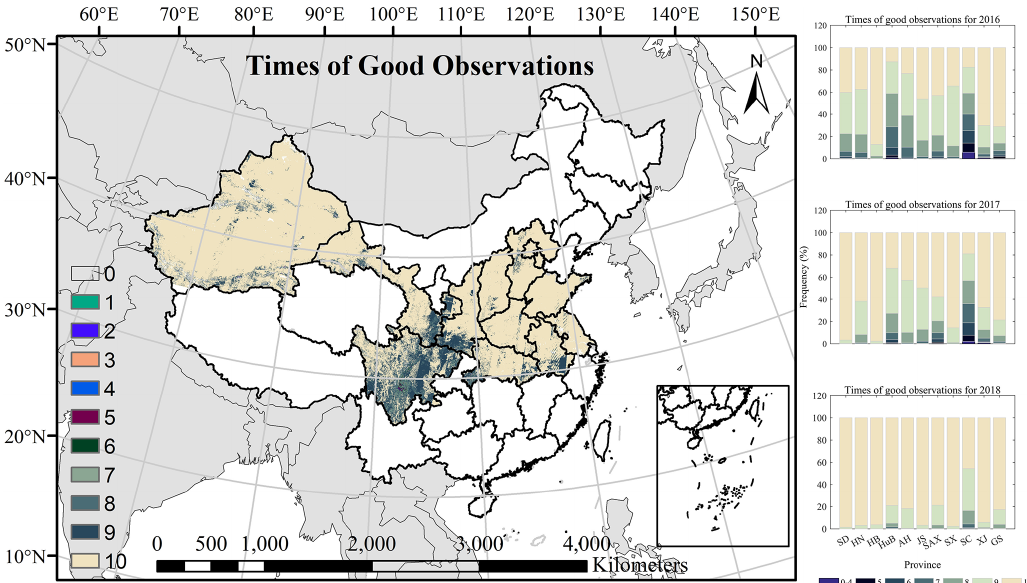
Figure 6. Times of good observations in the study area obtained from monthly maximum NDVI composite images between 1 October 2017 and 31 July 2018. The right column shows the frequency of the times of good observations during the period of 2016–2018 from October to the following July. Provincial administrative boundary data and global country administrative boundary data are sourced from http: //www.resdc.cn/DOI/ © Institute of Geographic Sciences and Natural Resources Research, Chinese Academy Sciences.